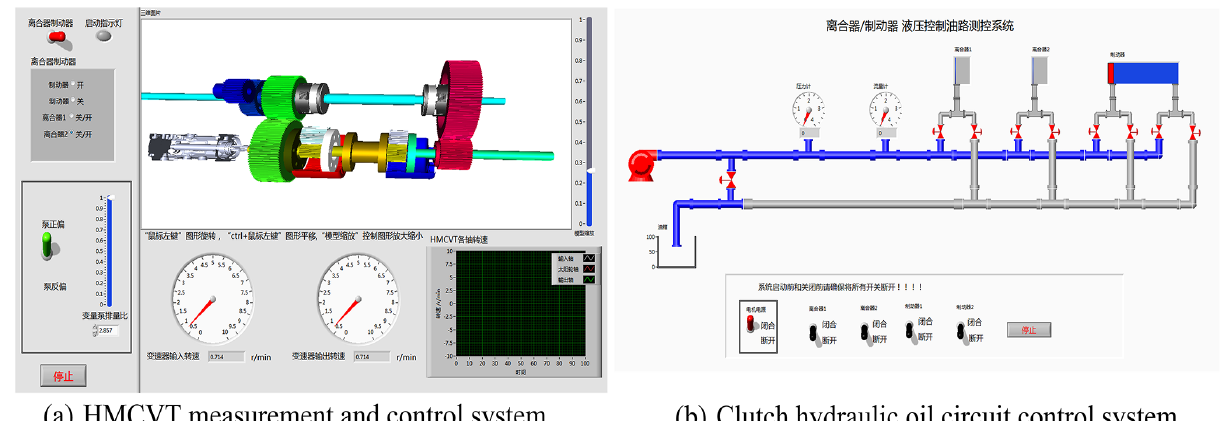
Figure 3. HMCVT control